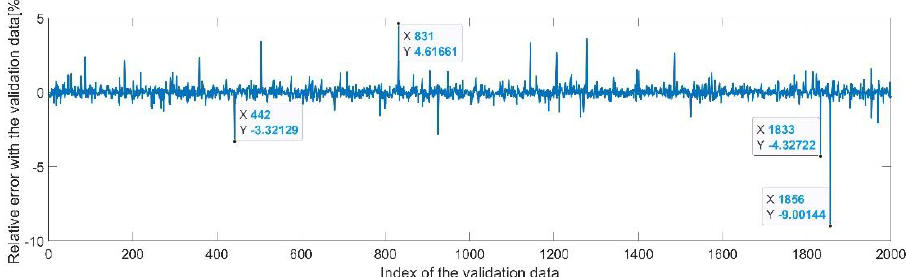
predicted value of 𝑞 4 ). predicted value of q 4 ).